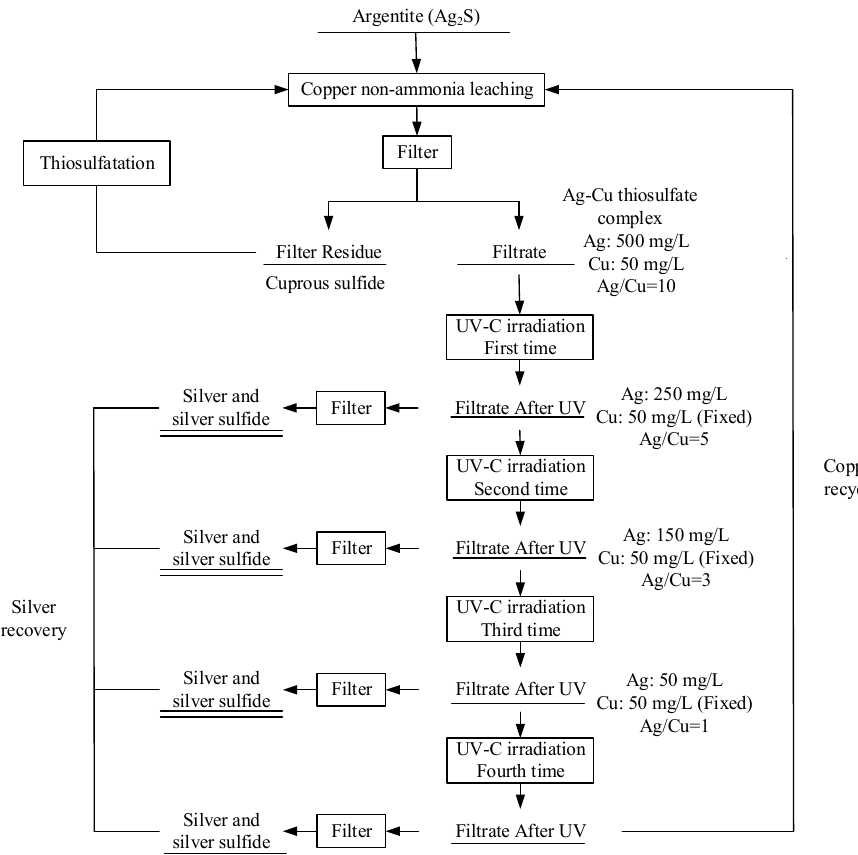
Figure 1. The flowchart of separation process.